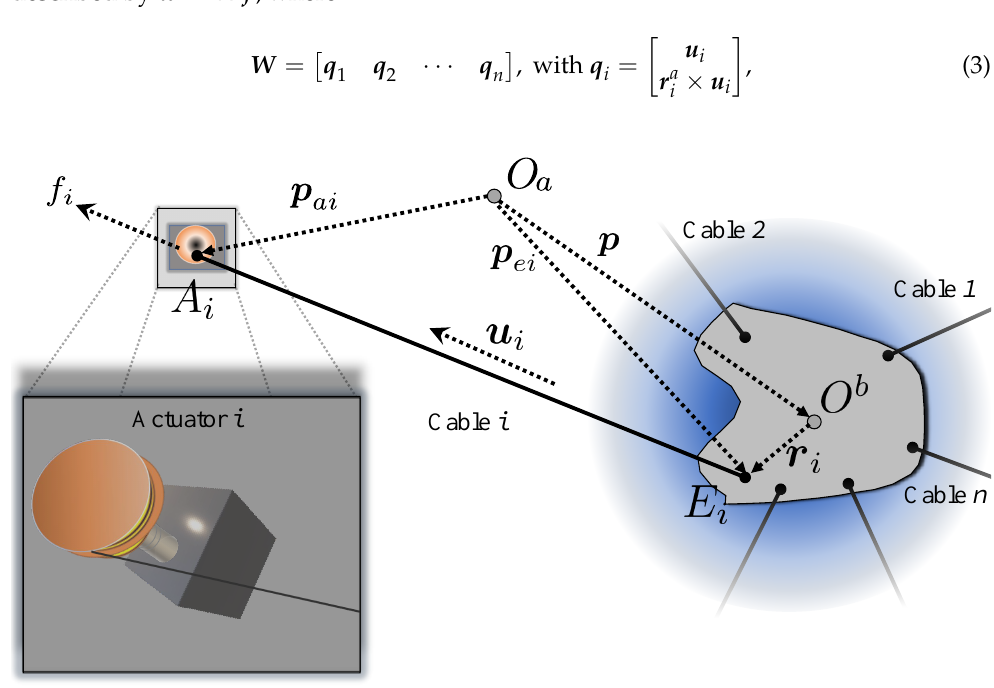
} : = ( p ) combined with the , p , · · · , p a a 1 a 2 an ) are referred to as the actuator configuration , r b , · · · , r b n 2 1